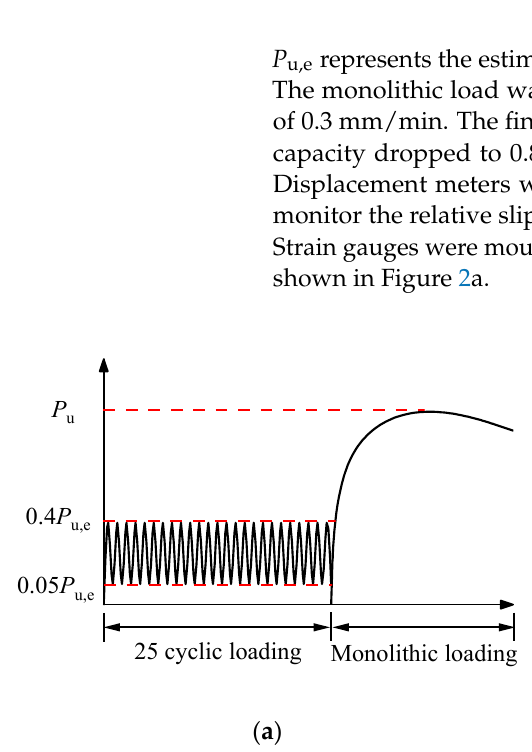
182.0 Table 2. Mechanical properties of concrete. Axial Compressive Strength f c (MPa)